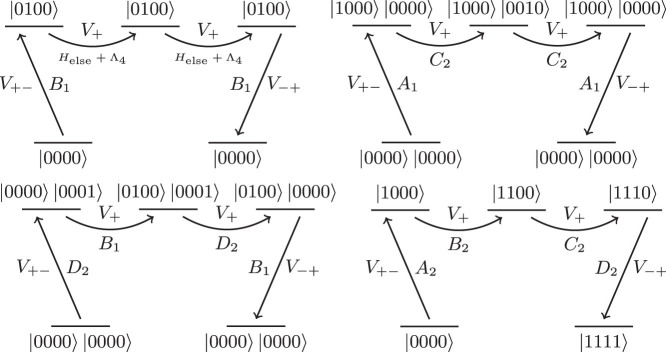
Diagrams showing an example of each of the four processes at fourth order.In the upper left is the process B1 (Helse + Λ)2
B1. In the upper right is the process . In the lower left is the process D2B1D2B1. In the lower right is the process A2B2C2D2.